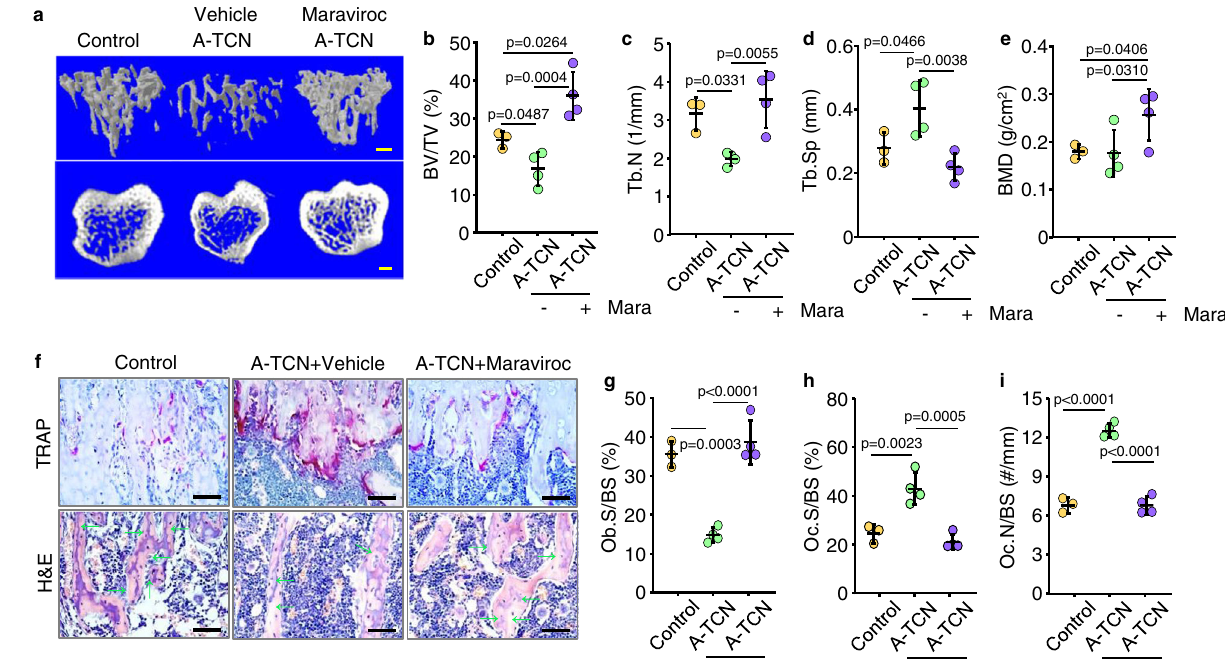
Fig. 6 | Maraviroc prevents bone loss caused by aged TCNs. a μ CT 3D recon- structionoftrabecularboneandcoronalsectionsoftibialmetaphysesofNSGmice injected with TCNs from aged C57 mice plus vehicle or maraviroc treatment. Bar=1mm. b – d Analysis of microstructure parameters in trabecular bones in ( a ), including trabecular bone volume (BV/TV) ( b ), number (Tb.N) ( c ) and separation (Tb.Sp) ( d ), and of bone mineral density (BMD) ( e ). Mean±SD ( n =3, 4, and 4 biologically independent male mice for control, A-TCN and A-TCN plus maraviroc